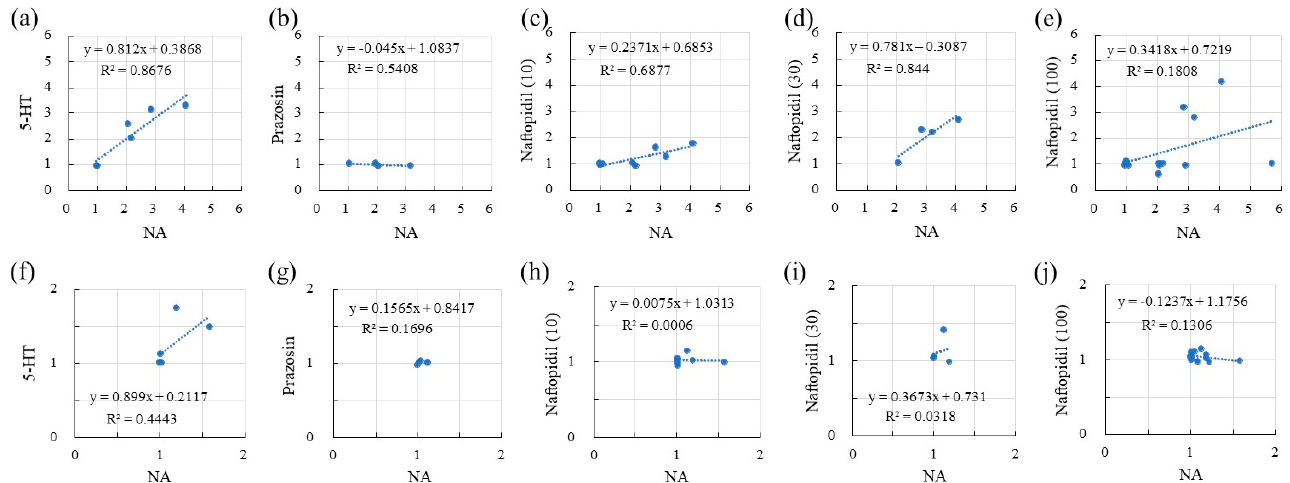
Conc, concentration; sEPSCs, spontaneous excitatory postsynaptic currents; sIPSCs, spontaneous inhibitorypost synaptic currents; R, correlation coefficient; R 2 , determination coefficient; 5-HT, serotonin.